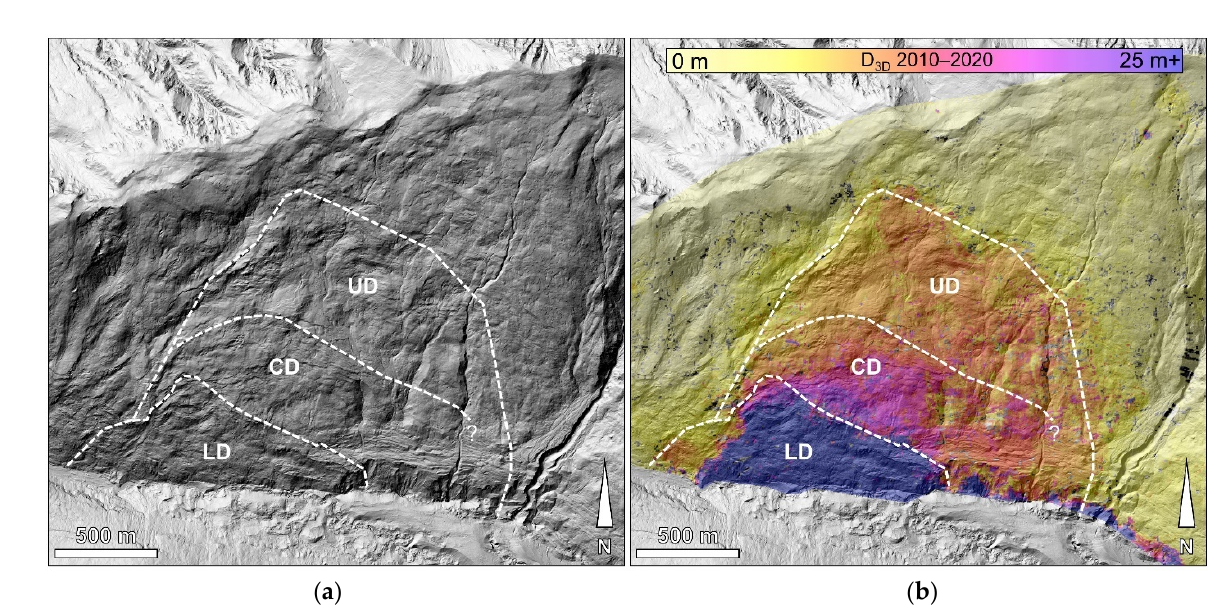
Figure 11. Fels landslide domains based on the combined ST-ALS analysis. ( a ) Domains shown on ALS hillshade base map. ( b ) Cumulative displacement magnitudes computed between 2010 and 2020. UD: upper domain; CD: central domain; LD: lower domain.